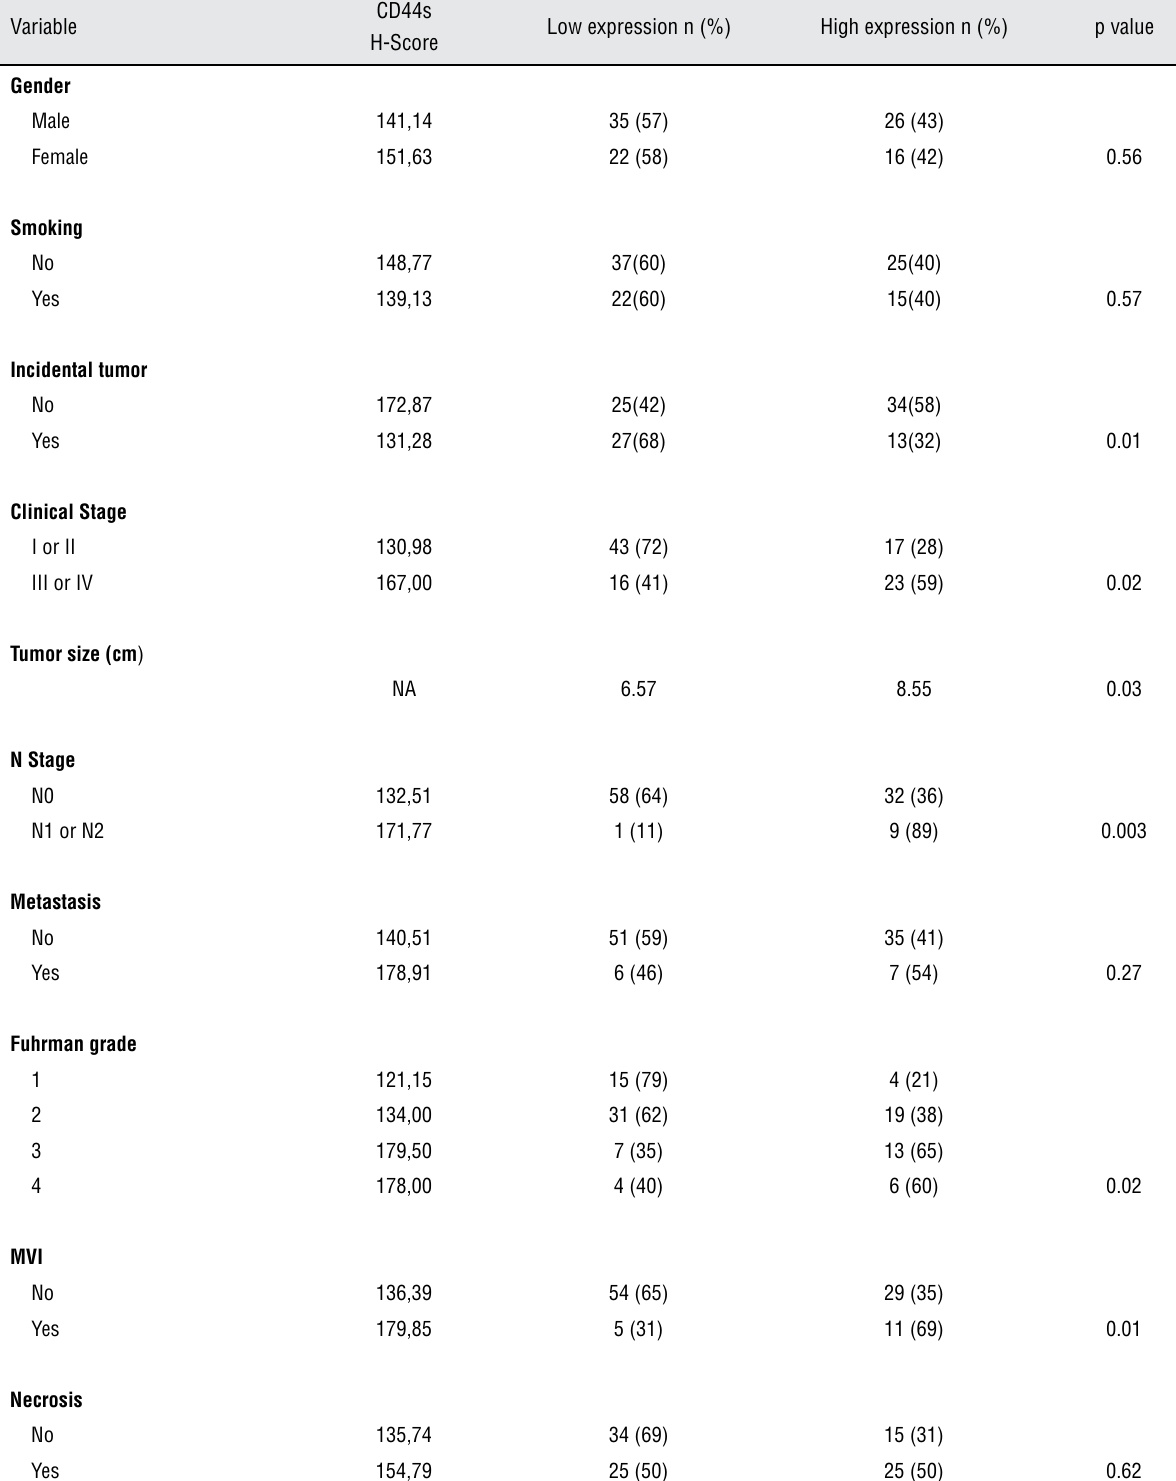
Table 1 - Patients, pathological characteristics, and association between variables and cD44s